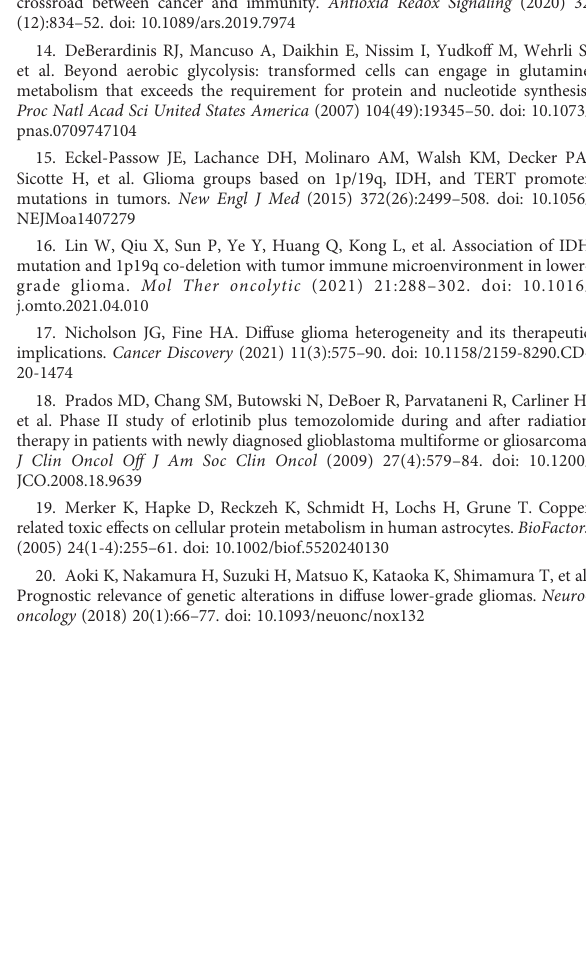
SUPPLEMENTARY FIGURE 1 Gene Set Enrichment Analysis (GSEA) of CARS.